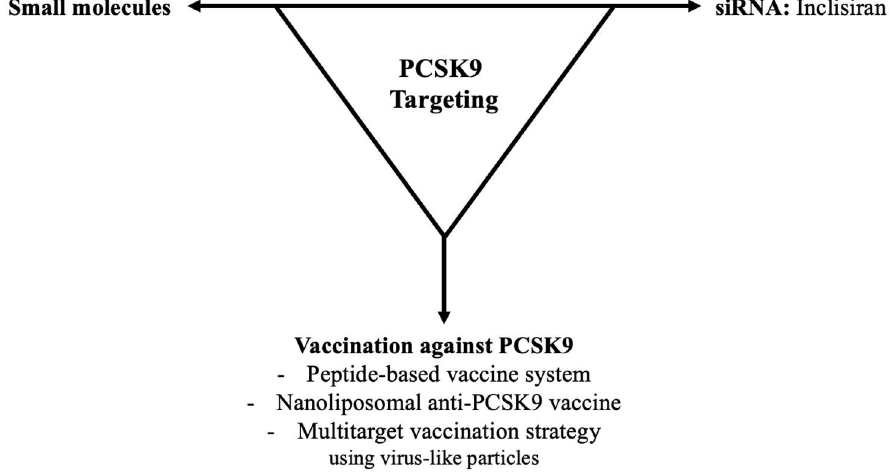
Figure 4. Proposed PCSK9 inhibition targeting in lipid-lowering therapy . siRNA: Inclisiran